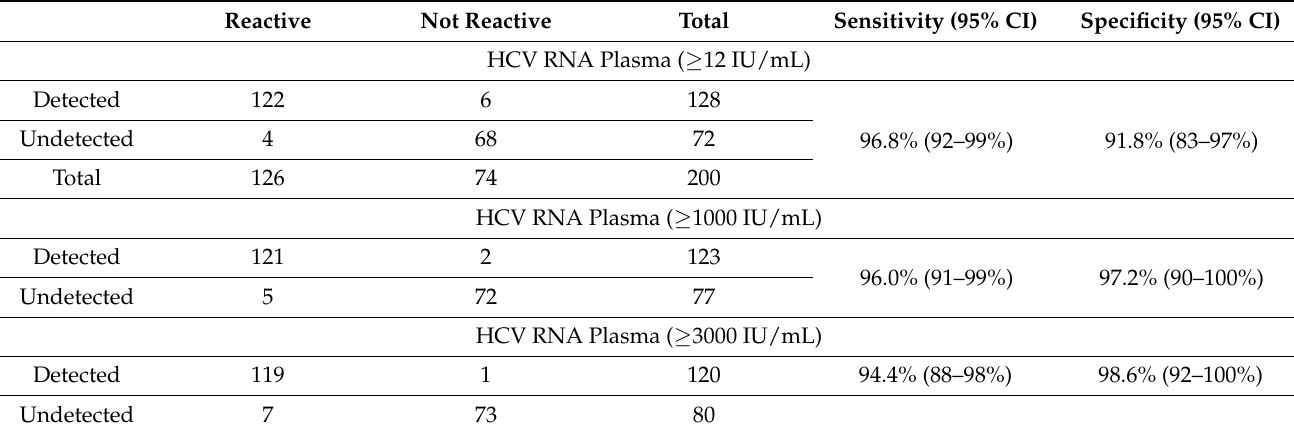
Table 2. Sensitivity and specificity of HCV core antigen plasma ( ≥ 3 fmol/L) compared with different HCV RNA thresholds.